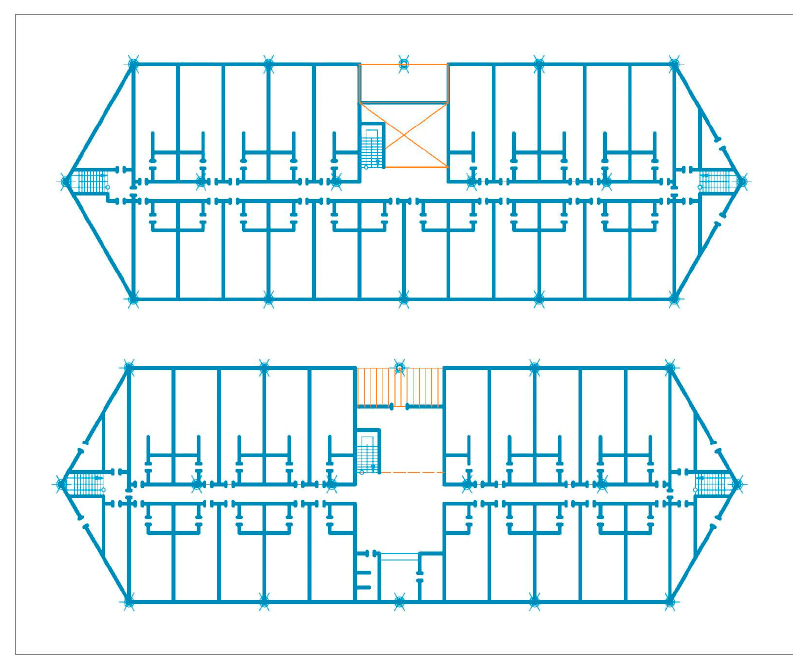
Figure 12. Planning solutions: the Ordinary Motel (24 rooms)—1st, 2nd floors.